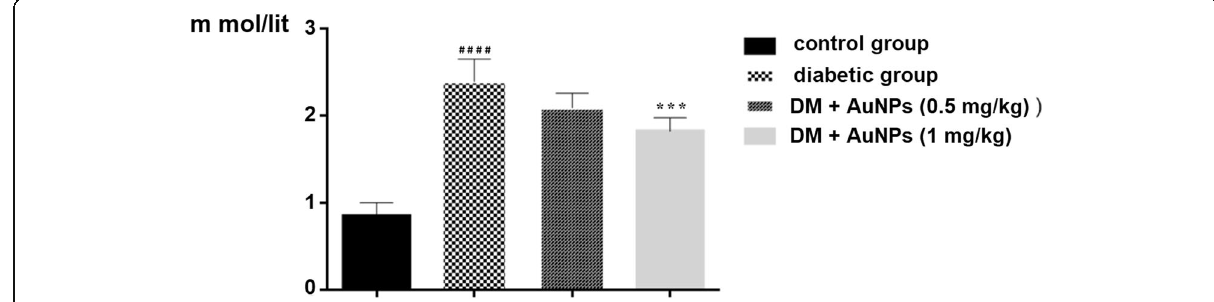
Fig. 6 Effect of AuNPs on malondialdehyde experimental groups of rats after 21 days treatment. Data are reported to mean ± SD of 5rats in each grou. *, **,***,and****represent statistically significant differences from Diabetic group at p < 0.05, 0.01,0.001 and 0.0001, respectively #, ##, ###, and ####represents statistically significant difference from control group at p < 0.05, 0.01,0.001 and 0.0001,